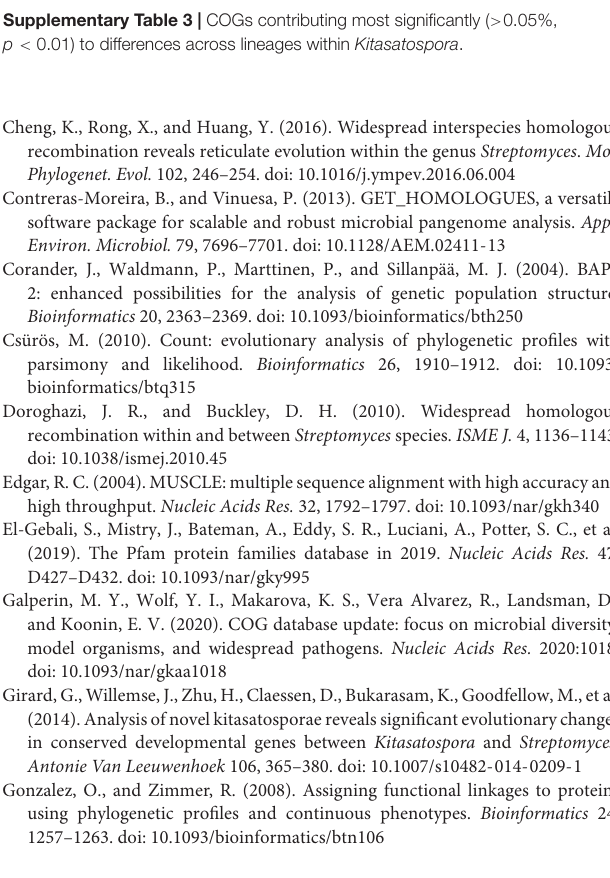
Supplementary Figure 2 | Hierarchical cluster analysis based on the presence or absence of dispensable genes. Supplementary Figure 3 | Comparison of the total number (A) , the total size (B) , and percentage of size (C) of smBGCs between genera. Supplementary Figure 4 | Distribution of biosynthetic gene clusters among strains of Kitasatospora . Supplementary Figure 5 | Ancestral reconstruction of smBGCFs in Kitasatospora using COUNT software. Supplementary Figure 6 | Genetic organizations of the BGCs discussed in the work. Supplementary Table 1 | Genomic features of Kitasatospora strains used in this